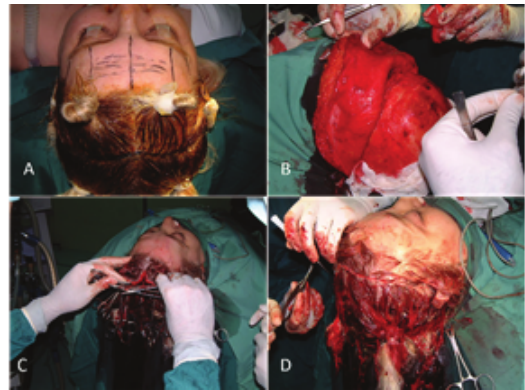
Figure 9. Cardinal steps of a transcoronal forehead lift include careful marking (A), complete release in the subperiosteal plane, up to the orbital rim (B), advancing the forehead flap over the scalp wound until the flap is moderately tight (C), and finally after excision of the excess segment and wound closure with staples